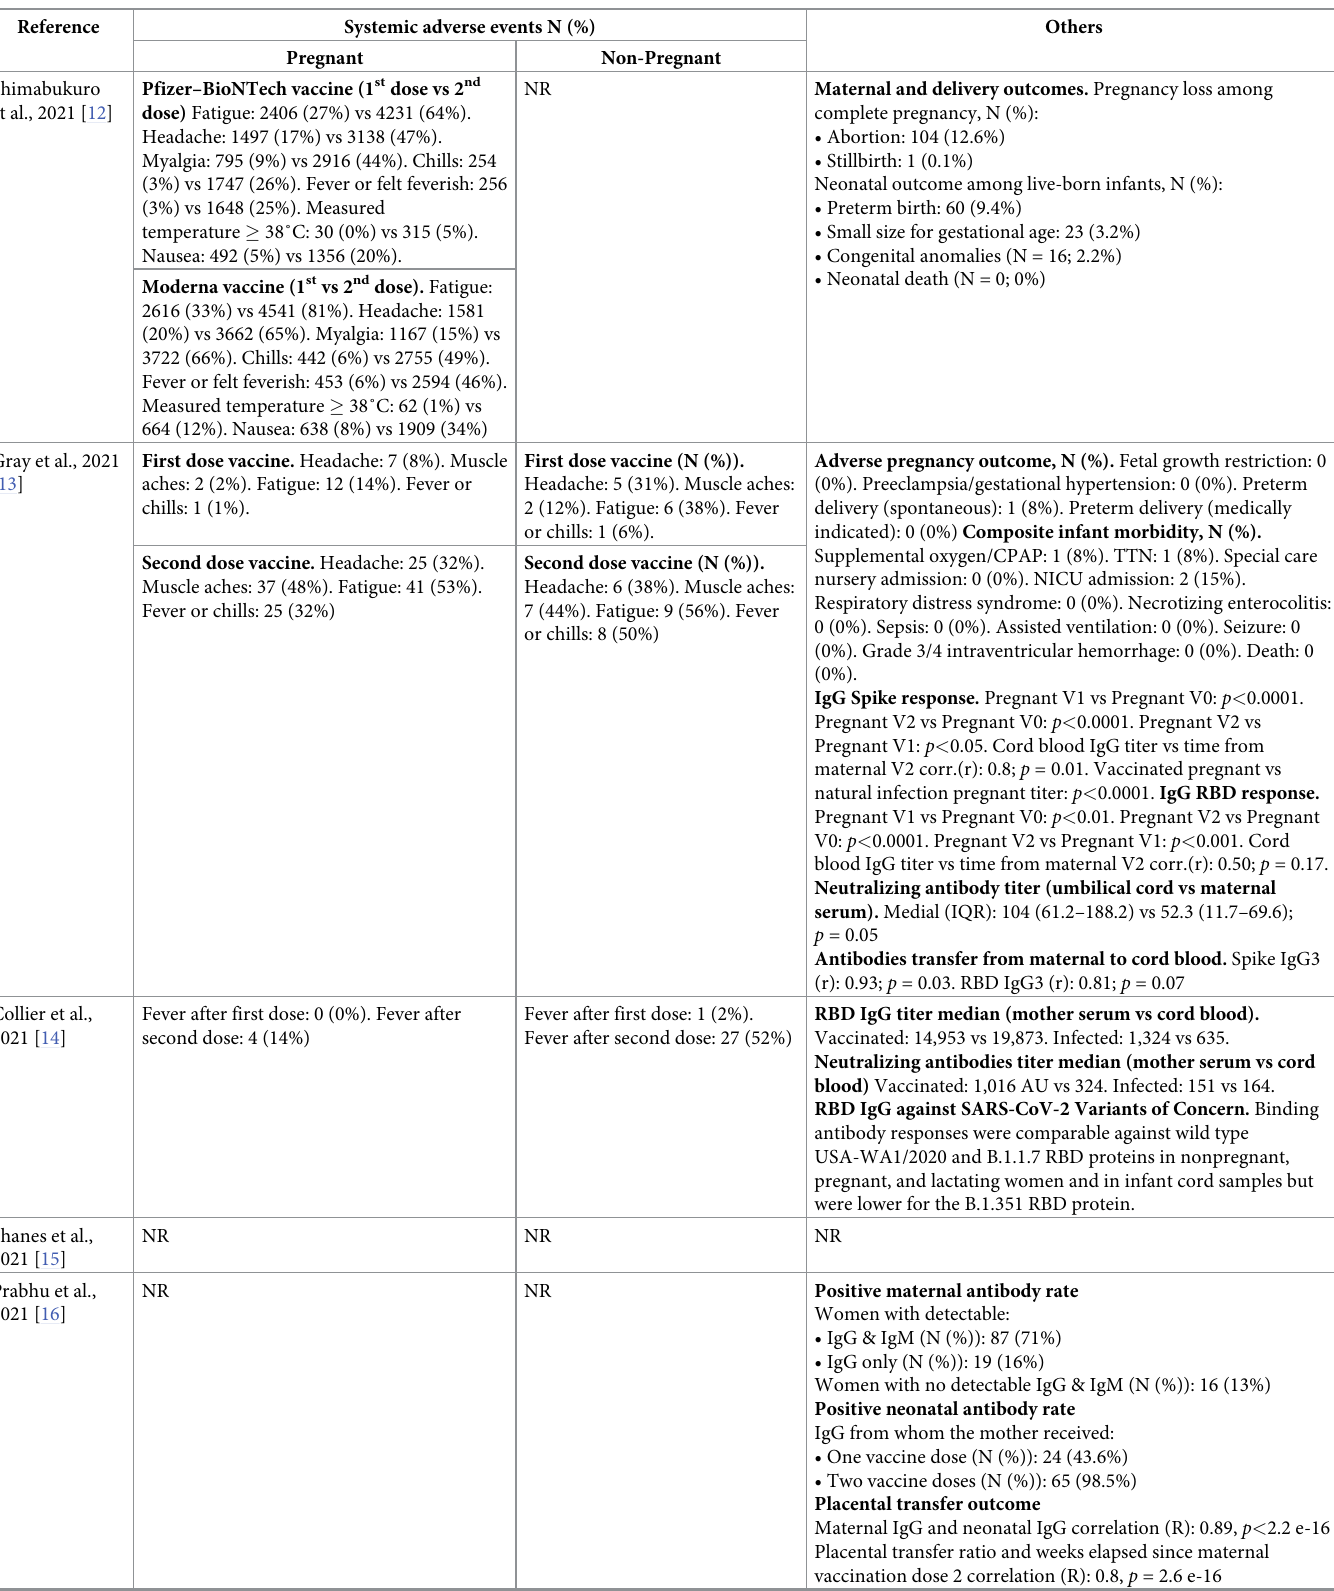
Table 3. Outcomes of the individual